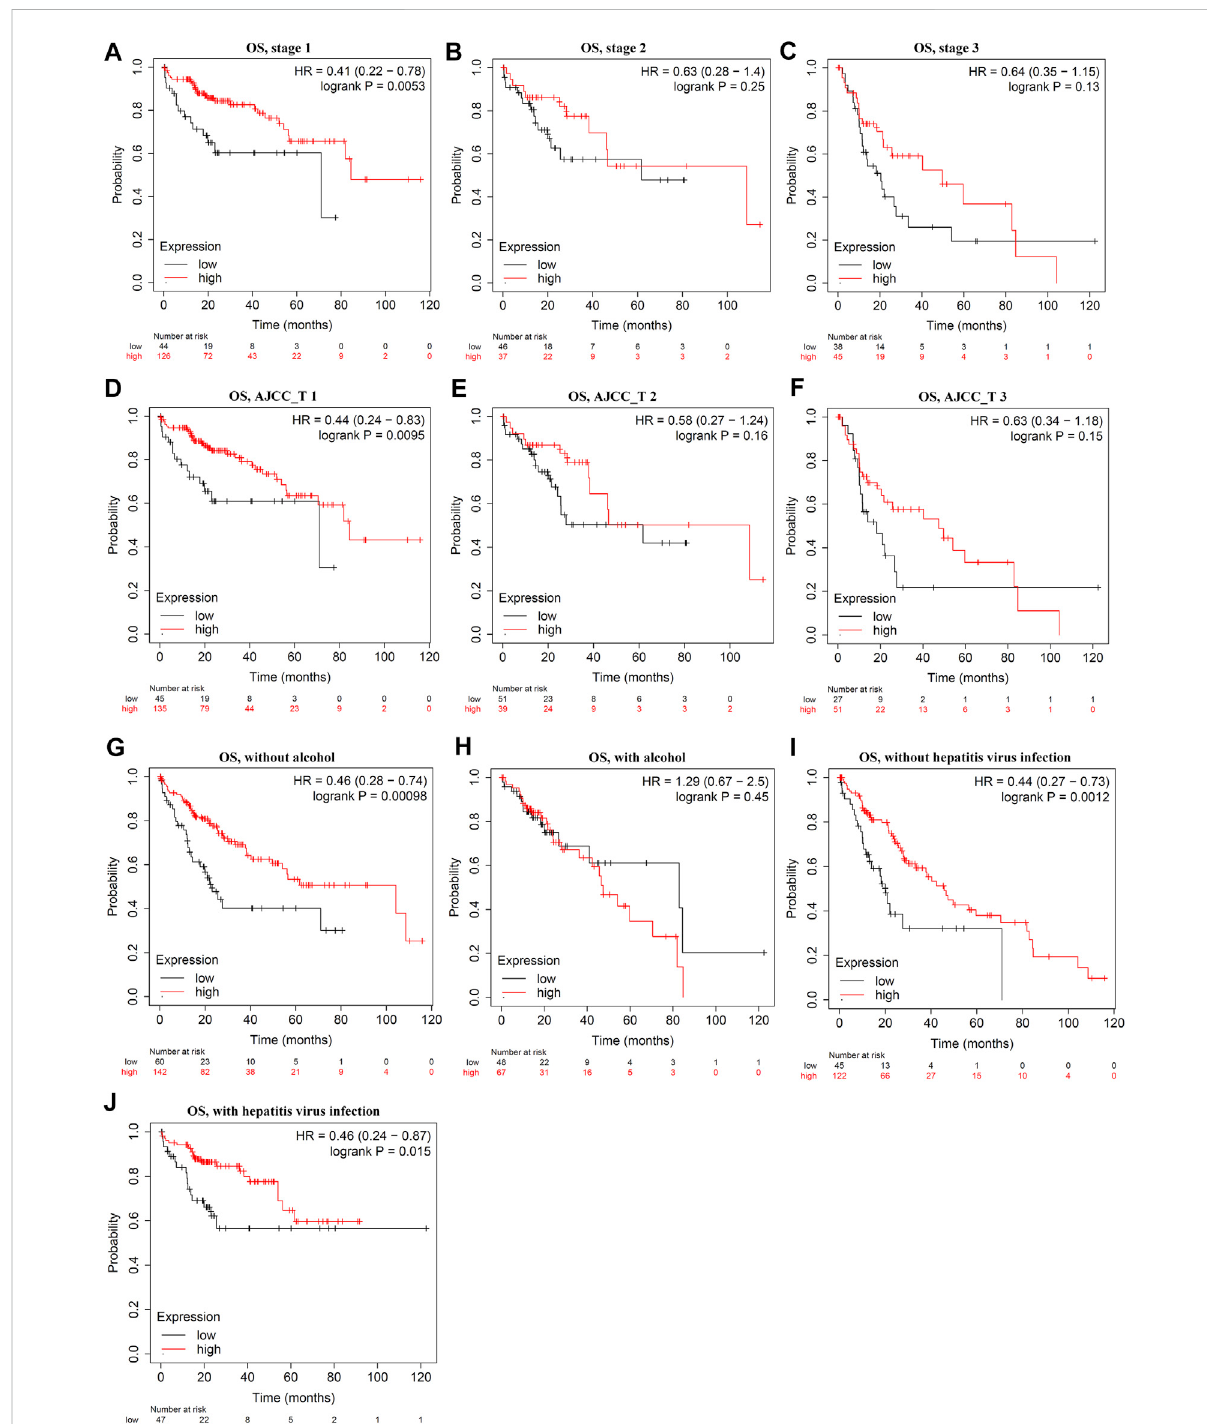
FIGURE 4 Strati fi ed analysis of overall survival (OS) by tumor stages, ATCC stages, alcohol intake, and hepatitis infection status. (A – C) Strati fi ed analysis of OS by tumor stages. (D – F) Strati fi ed analysis of OS by ATCC_T. (G,H) , Strati fi ed analysis of OS by alcohol intake. (I,J) Strati fi ed analysis of OS by hepatitis